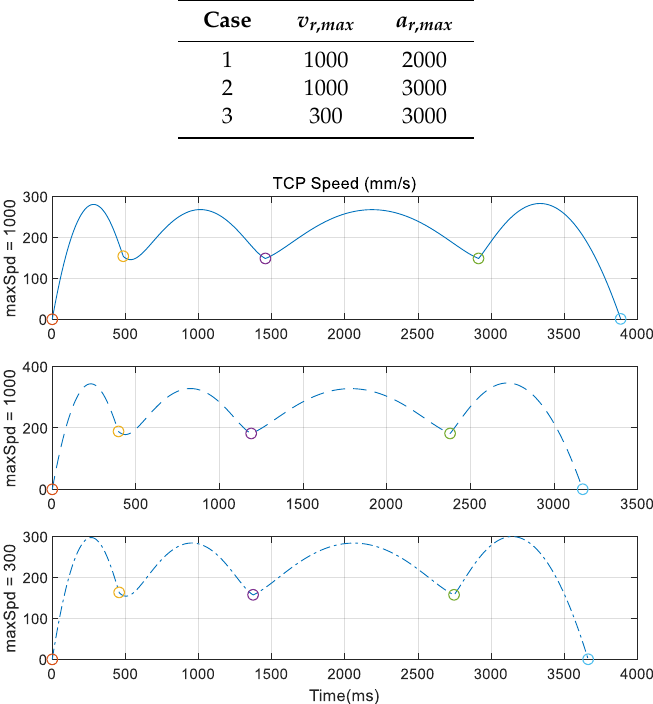
Figure 13. Velocity when assigned maximum velocity is changed.